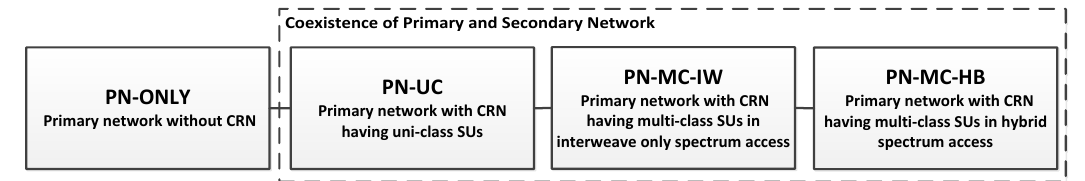
Figure 2. Set of cases for continuous time Markov chain (CTMC) Modelling.